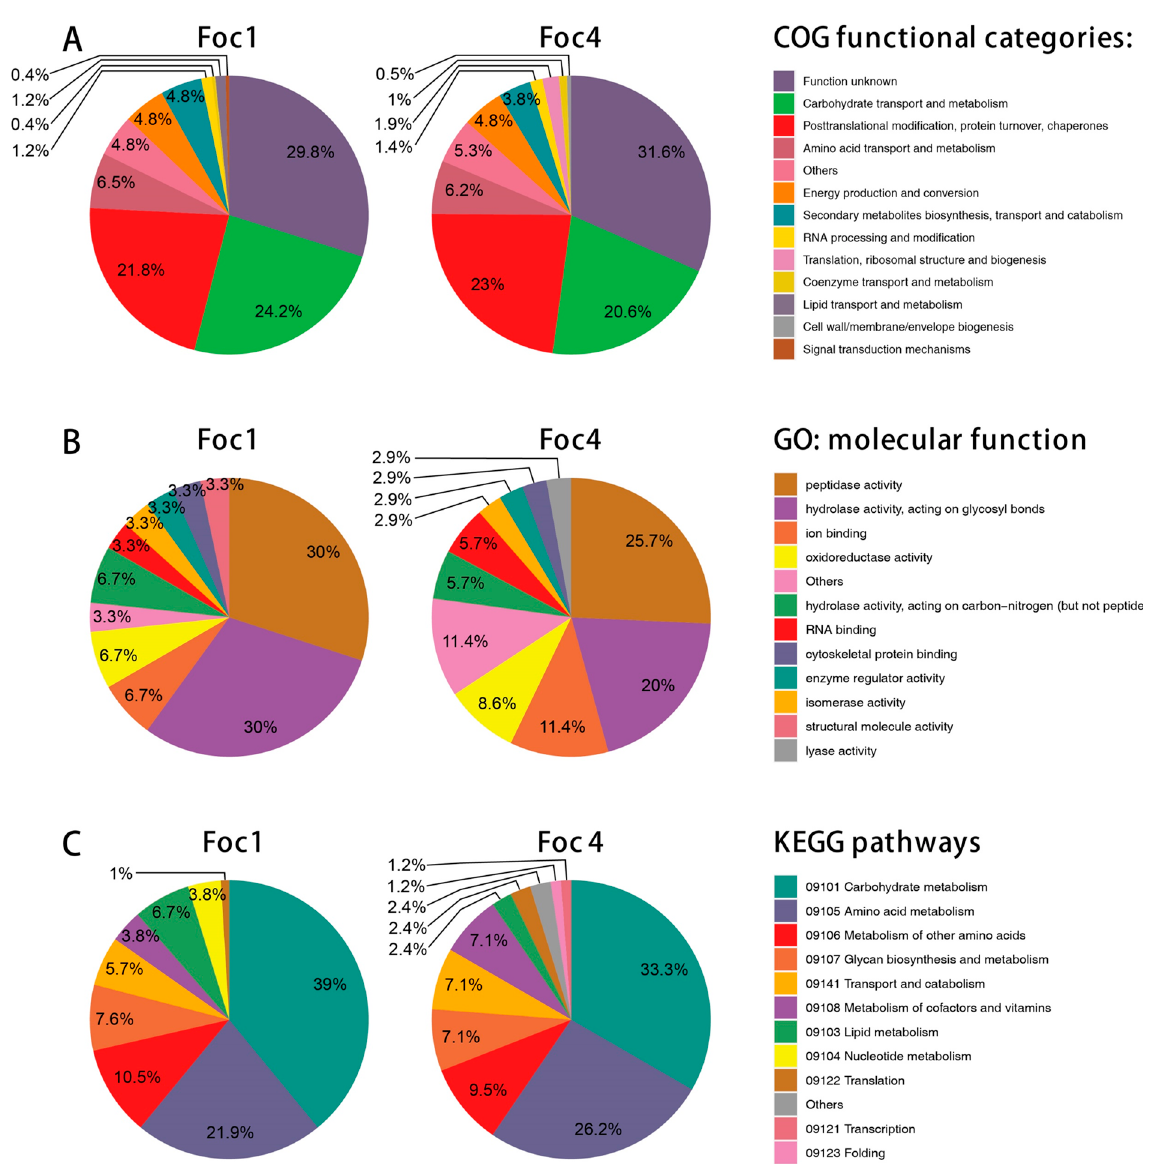
Figure 2. Functional annotations of the high confidence secretomes of Foc1 and Foc4. ( A ) COG functional categories; ( B ) GO molecular function terms; ( C ) KEGG pathways. The top 10 items in each type of functional annotations were shown.